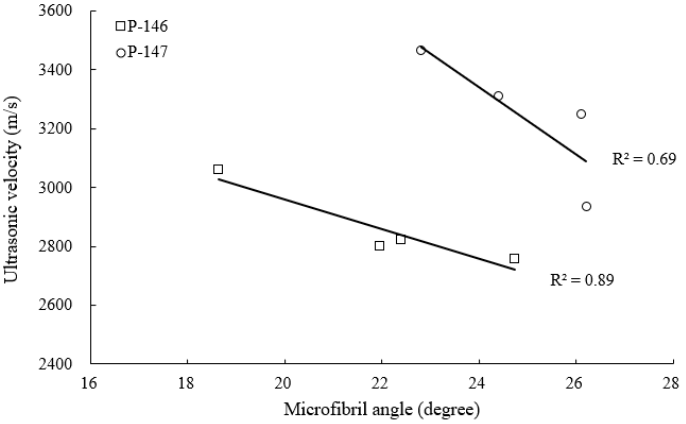
Figure 11. Relationship between the ultrasonic velocity and microfibril angle of poplar seedlings.